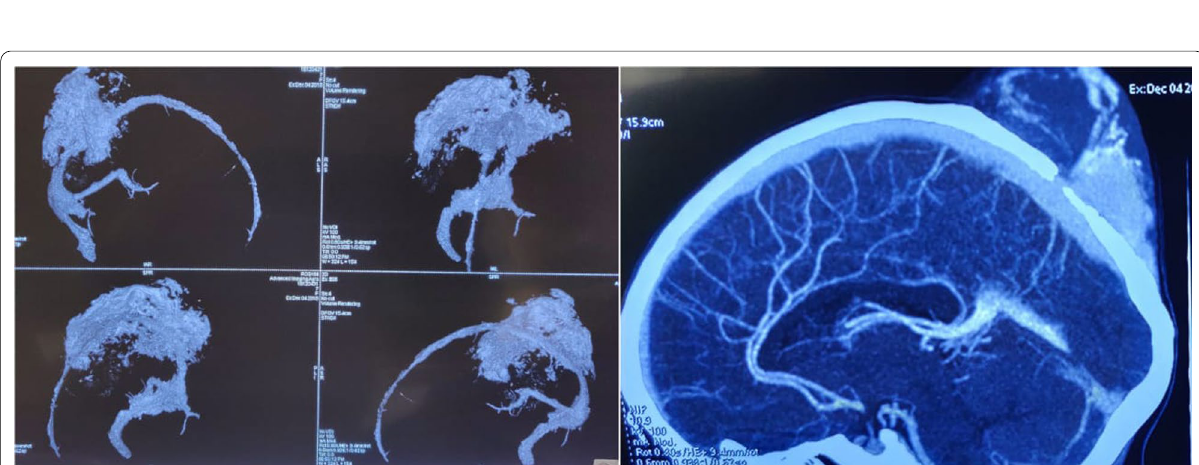
Fig. 4 MR venogram showing multiple large abnormal venous communications between superior sagittal sinus and the scalp swelling confirming dominant